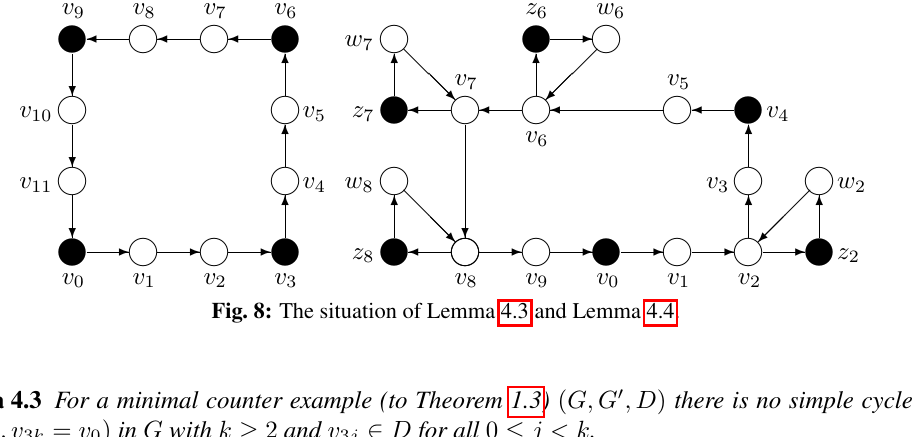
Fig. 8: The situation of Lemma 4.3 and Lemma